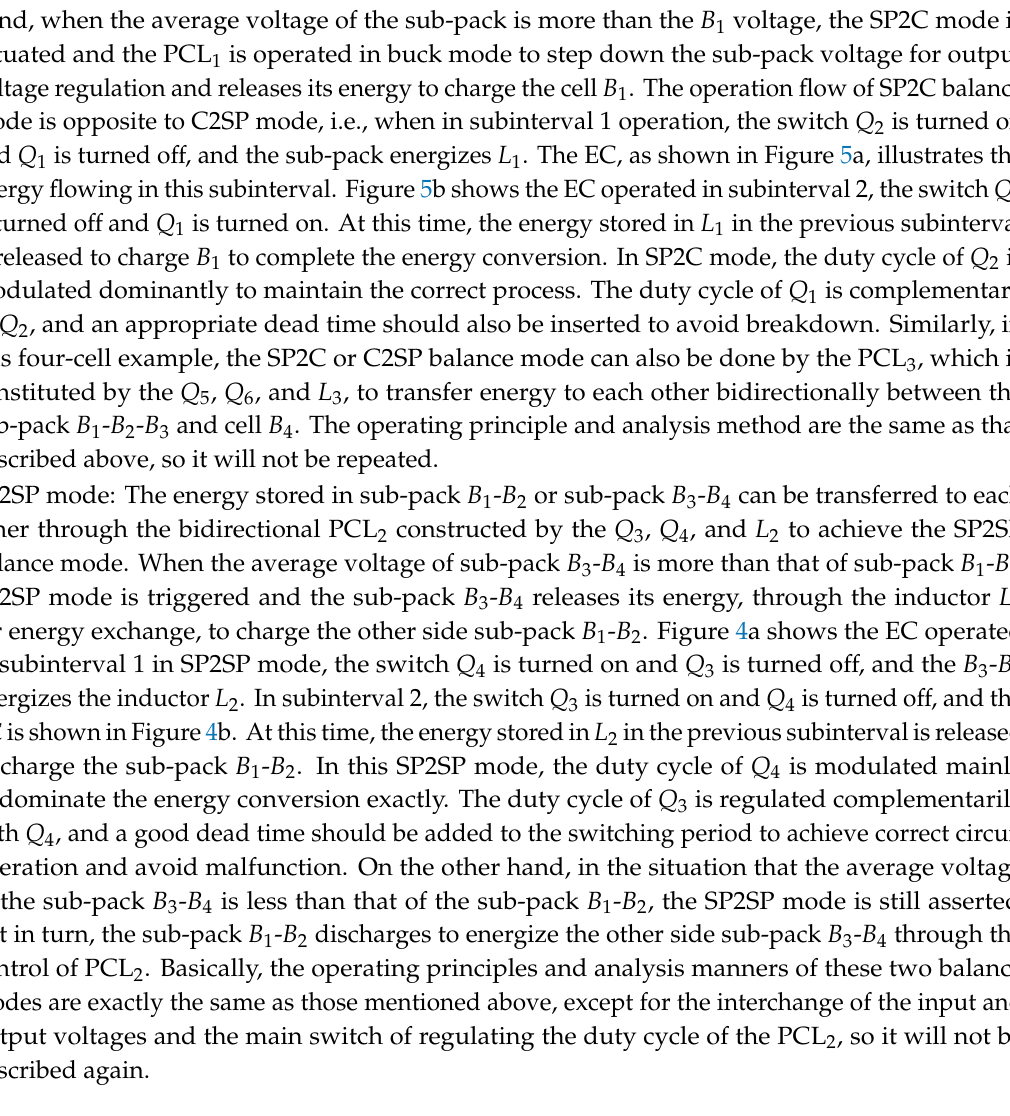
Figure 4. Operation of sub-pack-to-cell (SP2C) mode: ( a ) EC of subinterval 1, ( b ) EC of subinterval 2. • SP2SP mode: The energy stored in sub-pack B 1 - B 2 or sub-pack B 3 - B 4 can be transferred to each other through the bidirectional PCL 2 constructed by the Q 3 , Q 4 , and L 2 to achieve the SP2SP balance mode. When the average voltage of sub-pack B 3 - B 4 is more than that of sub-pack B 1 - B 2 , SP2SP mode is triggered and the sub-pack B 3 - B 4 releases its energy, through the inductor L 2 for energy exchange, to charge the other side sub-pack B 1 - B 2 . Figure 5a shows the EC operated in subinterval 1 in SP2SP mode, the switch Q 4 is turned on and Q 3 is turned off, and the B 3 - B 4 energizes the inductor L 2 . In subinterval 2, the switch Q 3 is turned on and Q 4 is turned off, and the EC is shown in Figure 5b. At this time, the energy stored in L 2 in the previous subinterval is released to charge the sub-pack B 1 - B 2 . In this SP2SP mode, the duty cycle of Q 4 is modulated mainly to dominate the energy conversion exactly. The duty cycle of Q 3 is regulated